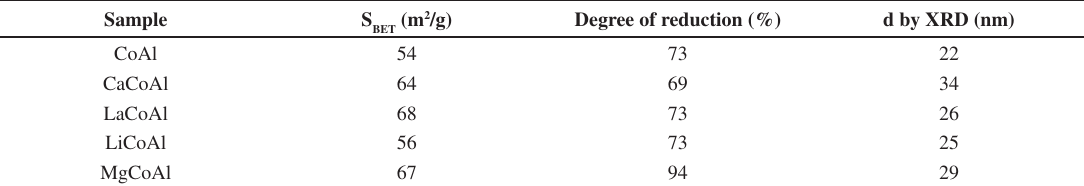
Figure 1. Thermogravimetric curves collected for the LiCoAl sample: weight (solid line), derivative thermogravimetry (dotted line) and differential thermal analysis (dashed line). Table 2. BET surface area, degree of reduction (%) and Co 0 apparent crystallite diameter by XRD for calcined and reduced samples, respectively.